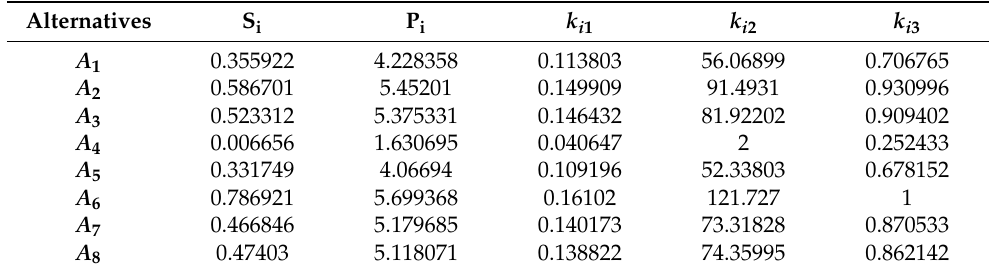
Table 9. Relative weight of alternatives.